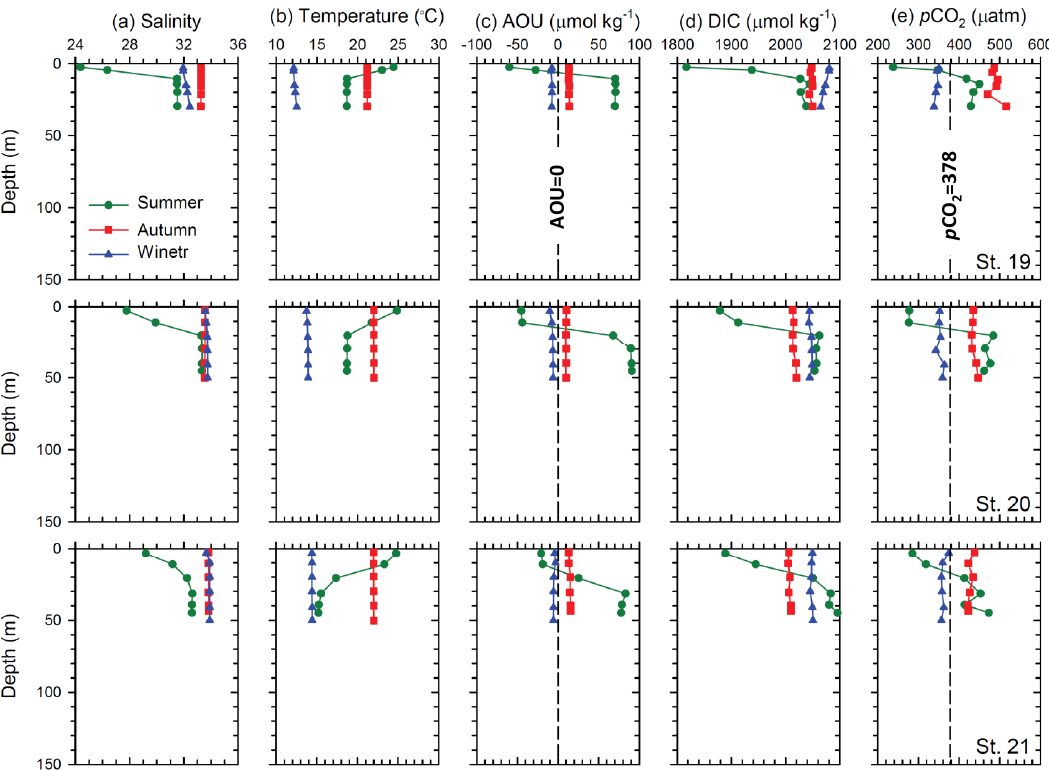
Fig. 3. Depth distributions of (a) salinity, (b) temperature, (c) AOU, (d) DIC and (e) p CO 2 in summer, autumn, and winter at the stations with the largest seasonal variation of p CO sw (stations 19, 20, and 21 in the inner shelf near the Changjiang 2